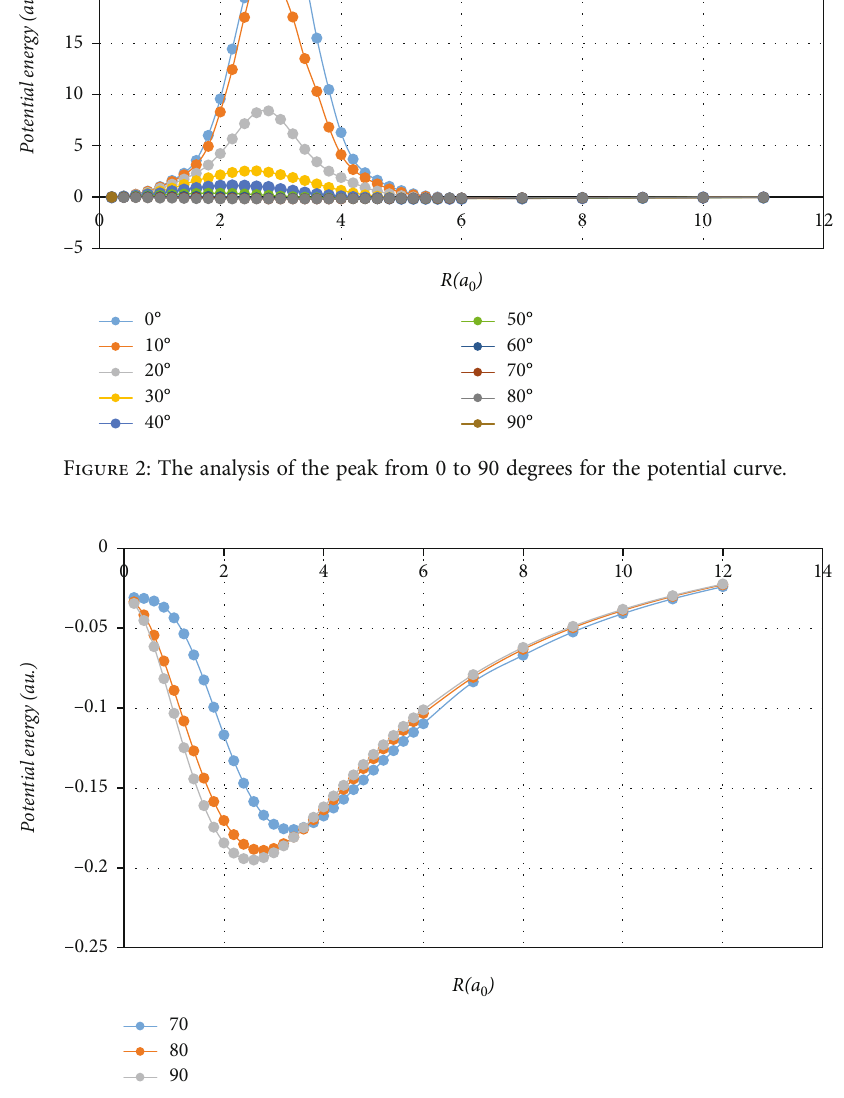
Figure 3: The analysis of the potential well from 70, 80, and 90 degrees for the potential